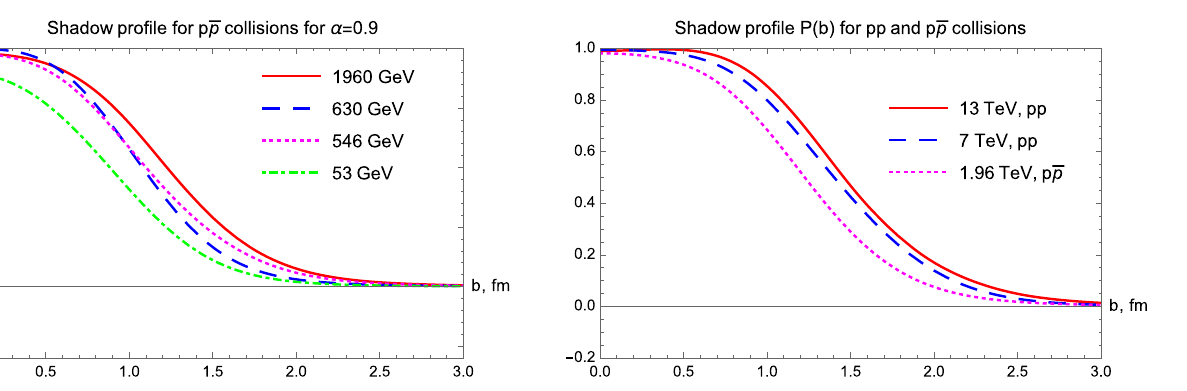
Fig. 9 Shadow profiles for p ¯ p collisions, or 0.5 fm saturated regions, the P ( b ) decreases nearly in